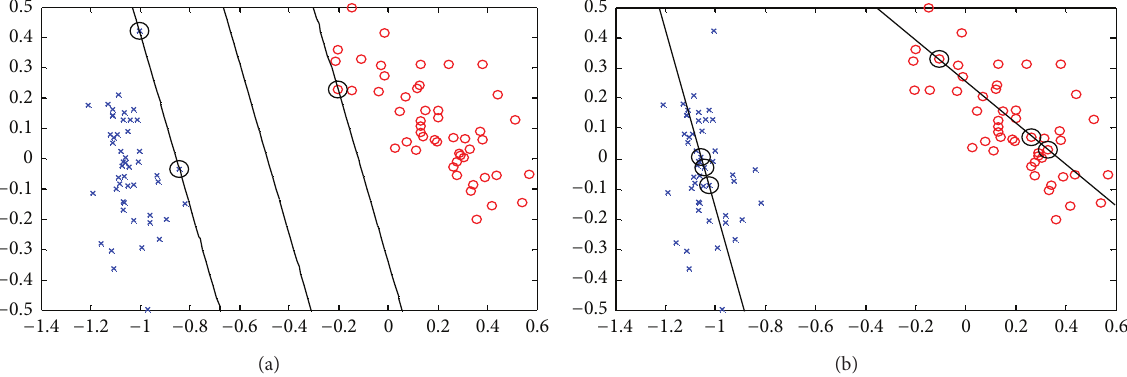
Figure 2: An example of SVMs and TWSVMs: ( a ) SVMs and ( b ) TWSVMs. All the points of class +1 are represented by a “ × ” and those of class − 1 by “ I